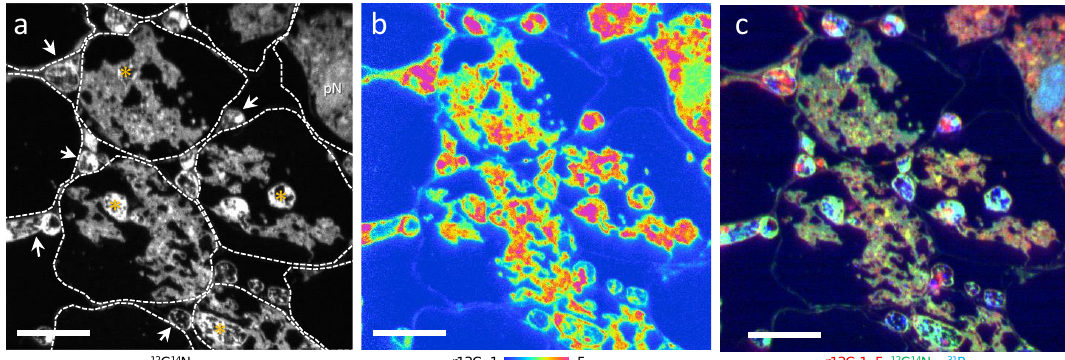
Figure 1. A part of 13 CO 2 labelled Allium cepa mycorrhizal root section colonized with Gigaspora margarita (ims-1270 equipped with SCAPS). Cells showing intercellular hyphae (arrowheads) and arbuscules composed of trunk hyphae (*) and fine branches. Fine branches are surrounded by plant cytoplasm. ( a ) 12 C 14 N image. Boundaries of plant cells are shown by dotted lines. ( b ) 13 C/ 12 C × 100 (r13C). ( c ) Overlay images of r13C (red), 12 C 14 N (green), and 31 P (blue). pN, plant nucleus. Bars: 20 μm.